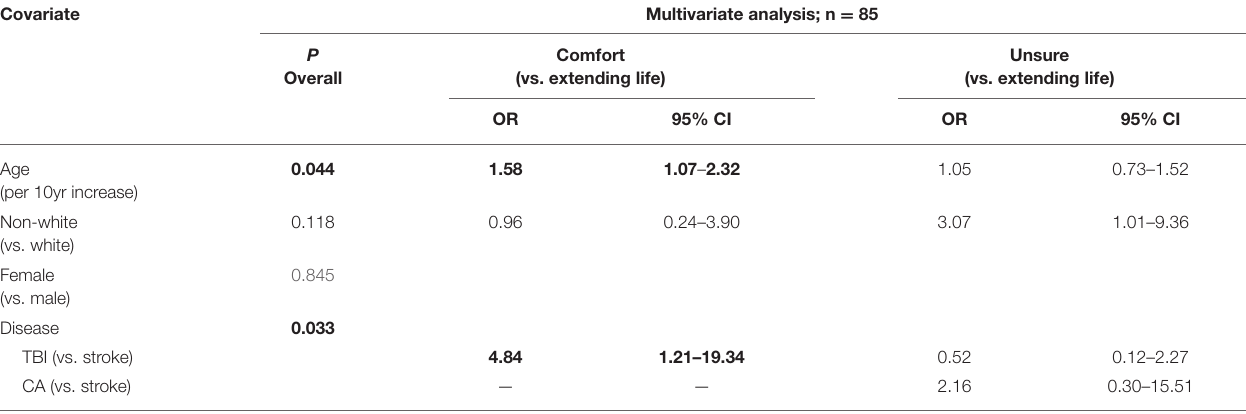
TABLE 4 | Determinants of presumed prioritized healthcare goals in the post-acute setting (148 days after enrollment). Covariate Multivariate analysis; n =